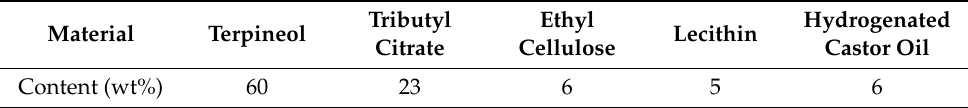
Table 6. Composition of the organic carrier.